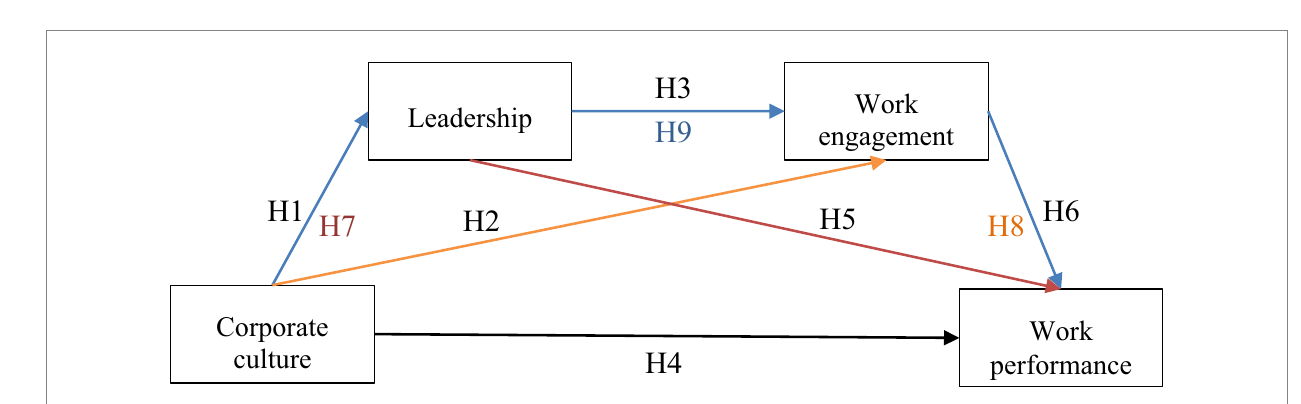
FIGURE 1 Diagram of serial mediation with two mediators according to the research variables and hypothesis.